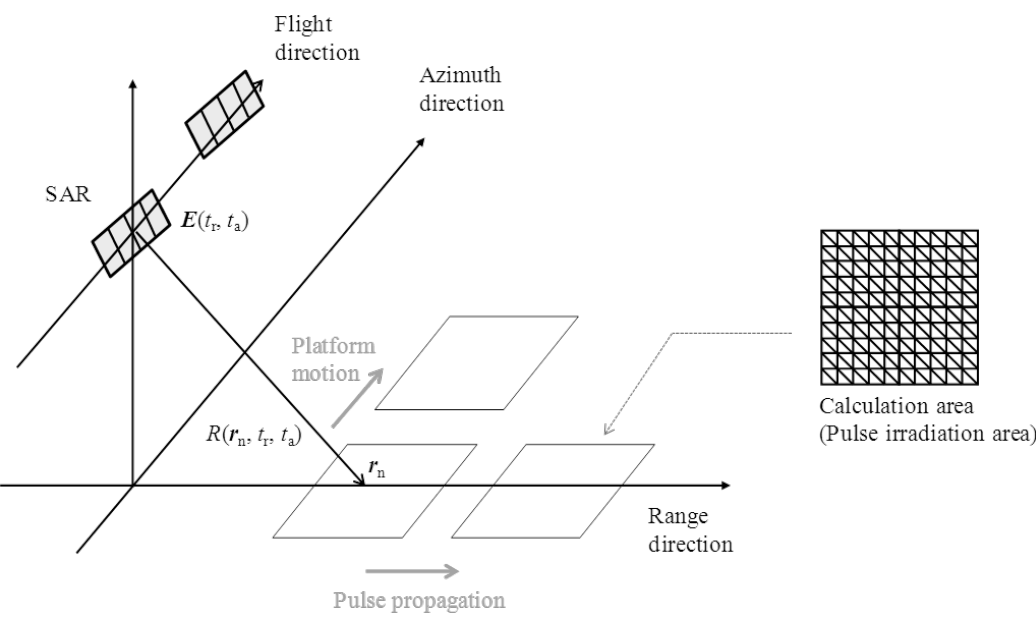
Figure 1. Conceptual figure of SAR image simulation in time